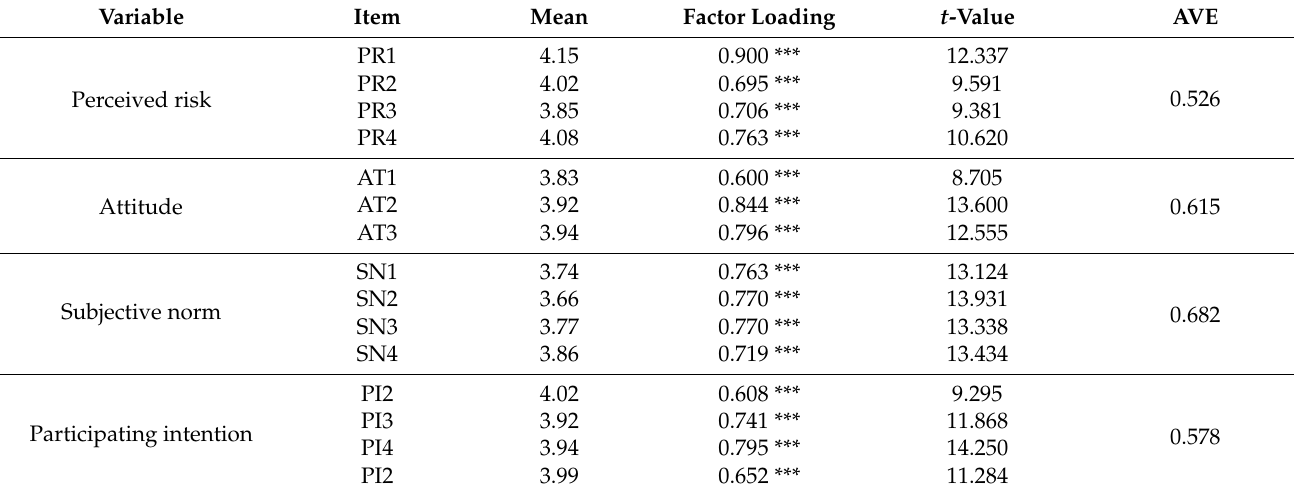
Table 4. The CFA results.